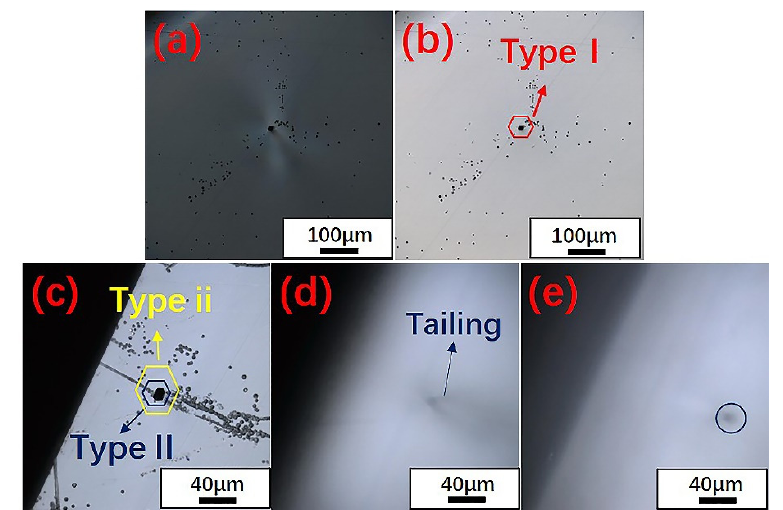
Figure 8. Classification of 6H-SiC micropipe etch pits: ( a ) transmitted polarized microscopic image of the area shown in ( b ); ( b ) Type I micropipe etch pits observed with a 20× lens; ( c ) Type ii and Type II micropipe etch pits observed with a 50× lens; ( d ) tailing of Type II micropipe etch pits when the focal length was changed; ( e ) black spots formed on the back by the Type II micropipe etch pits.